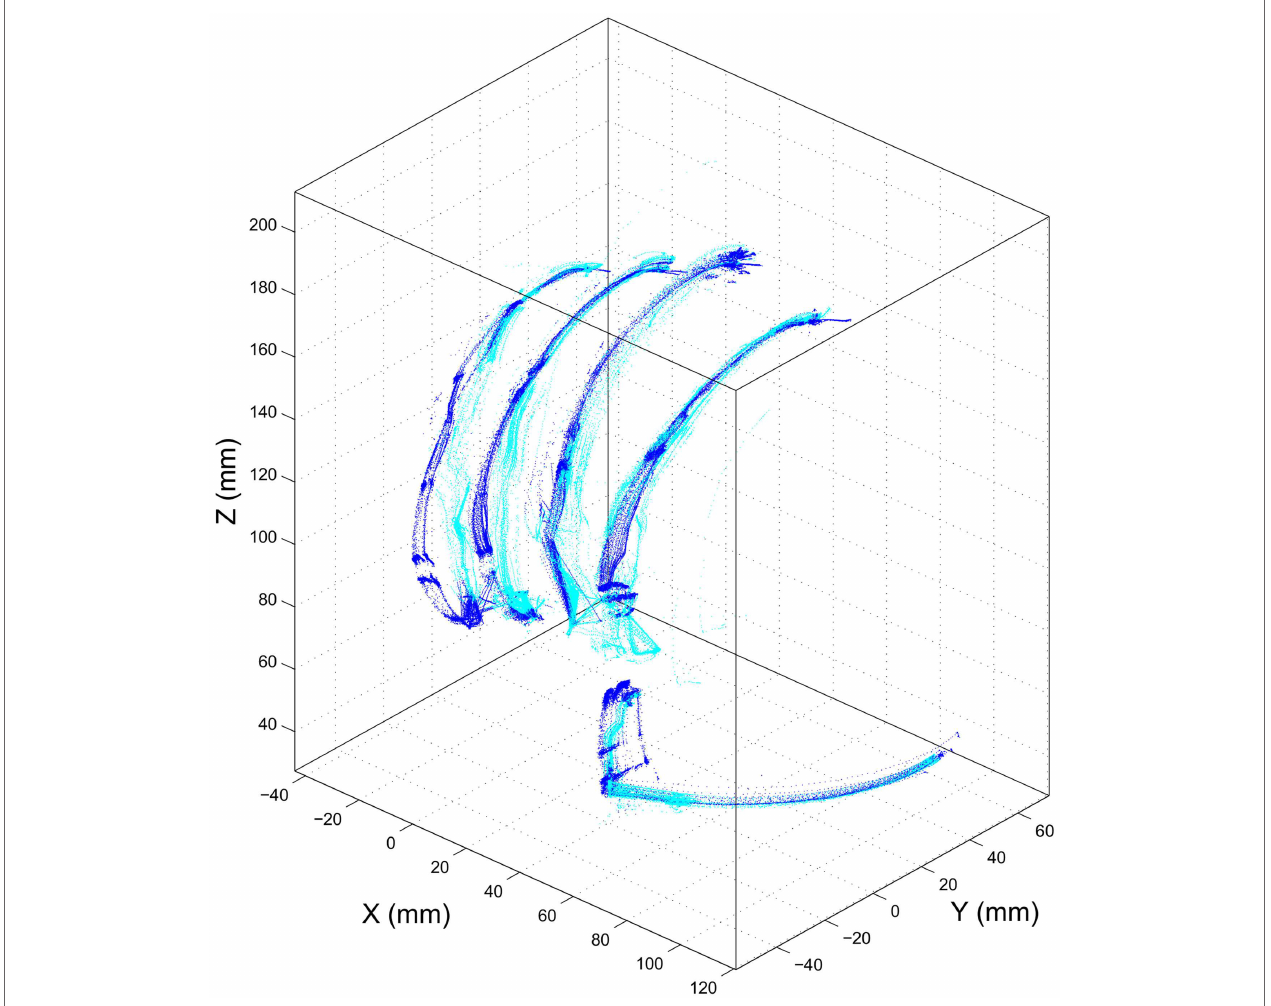
FIGURE 5 | Experiment 1 : path of SH-P fingertip in three-dimensional coordinates . Dark and light blue traces denote hand closing and opening paths, respectively.